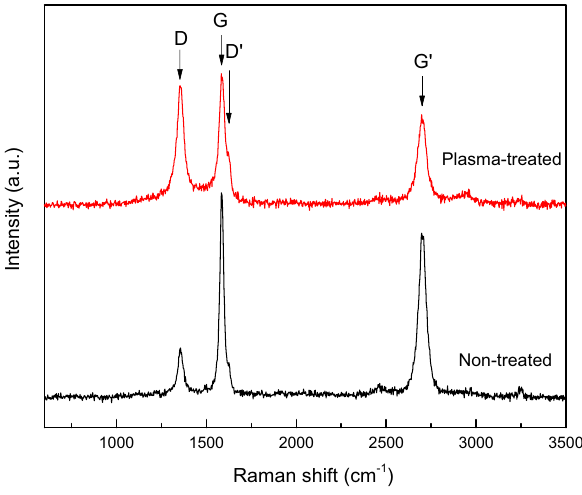
Fig. 2 Raman spectra of the original and plasma-etched carbon paper, showing the main Raman features of graphite: the D , G , D ′ and G ′ bands